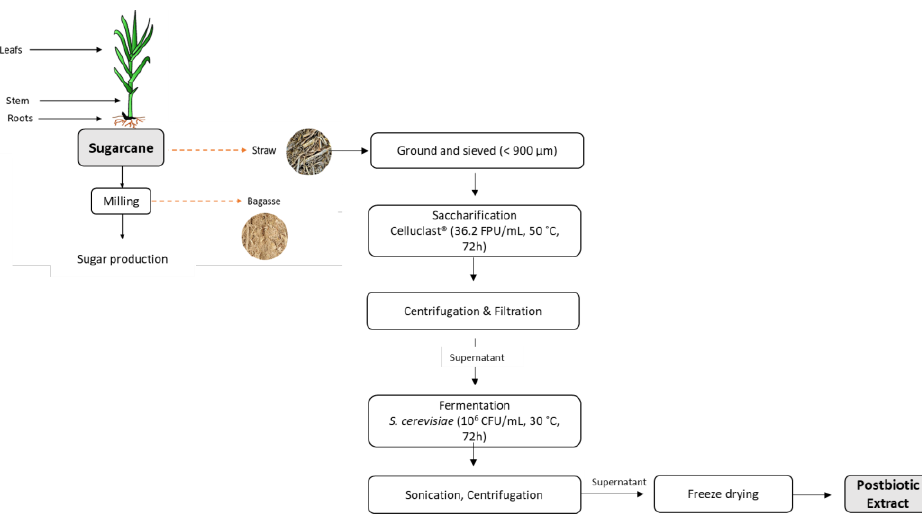
Figure 1. Scheme of sugarcane straw postbiotic extract production.